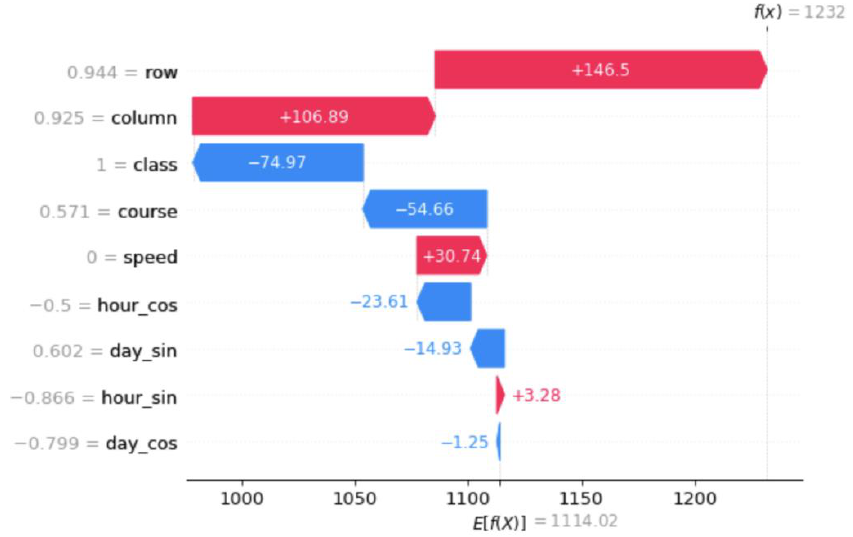
Figure 9. The contribution of each input feature to build the output predicted by KNN for ship 81.